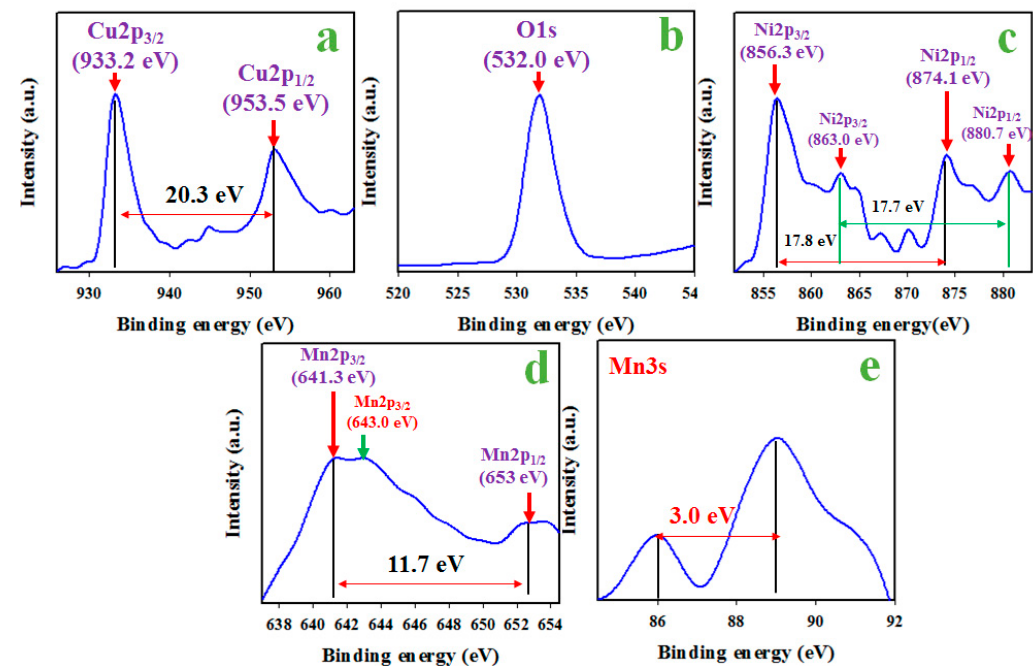
Figure 1. XPS analysis of low-dimensional nano-formulated porous mixed metal oxide nanomaterials (CMNO NMs) by X-ray photoelectron spectroscopy. The XPS spectrum of ( a ) spin-orbital of Cu2p level, ( b ) O1s orbit, ( c ) high-resolution XPS spectrum of Ni2p level, and ( d ) Mn2p spin orbits and ( e ) Mn3s level.